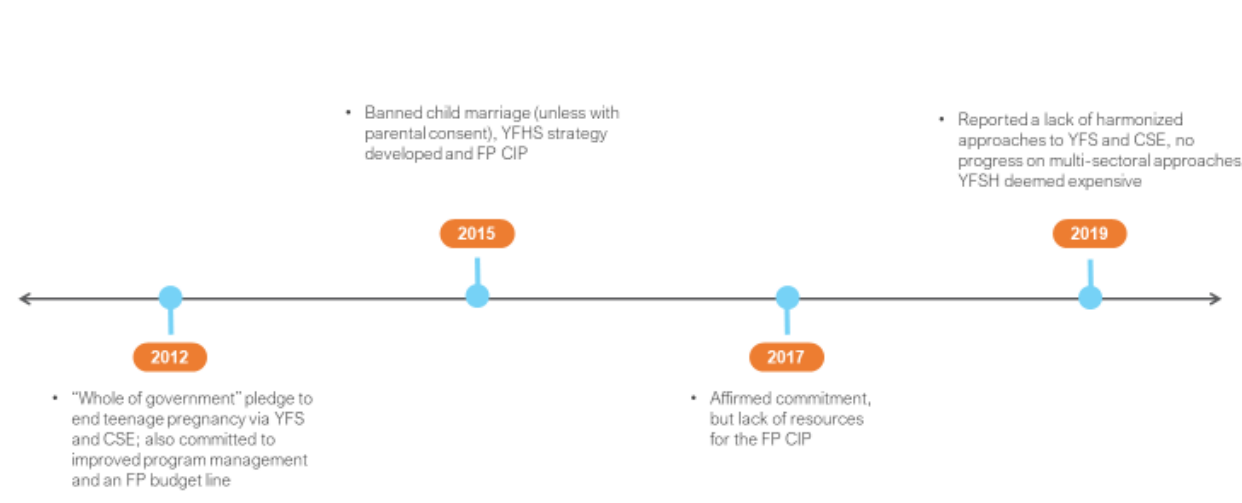
Figure 6. Malawi FP2020 commitments and timeline. YFS – youth friendly services; CSE – comprehensive sexuality education; YFHS – youth friendly health services; CIP – costed implementation